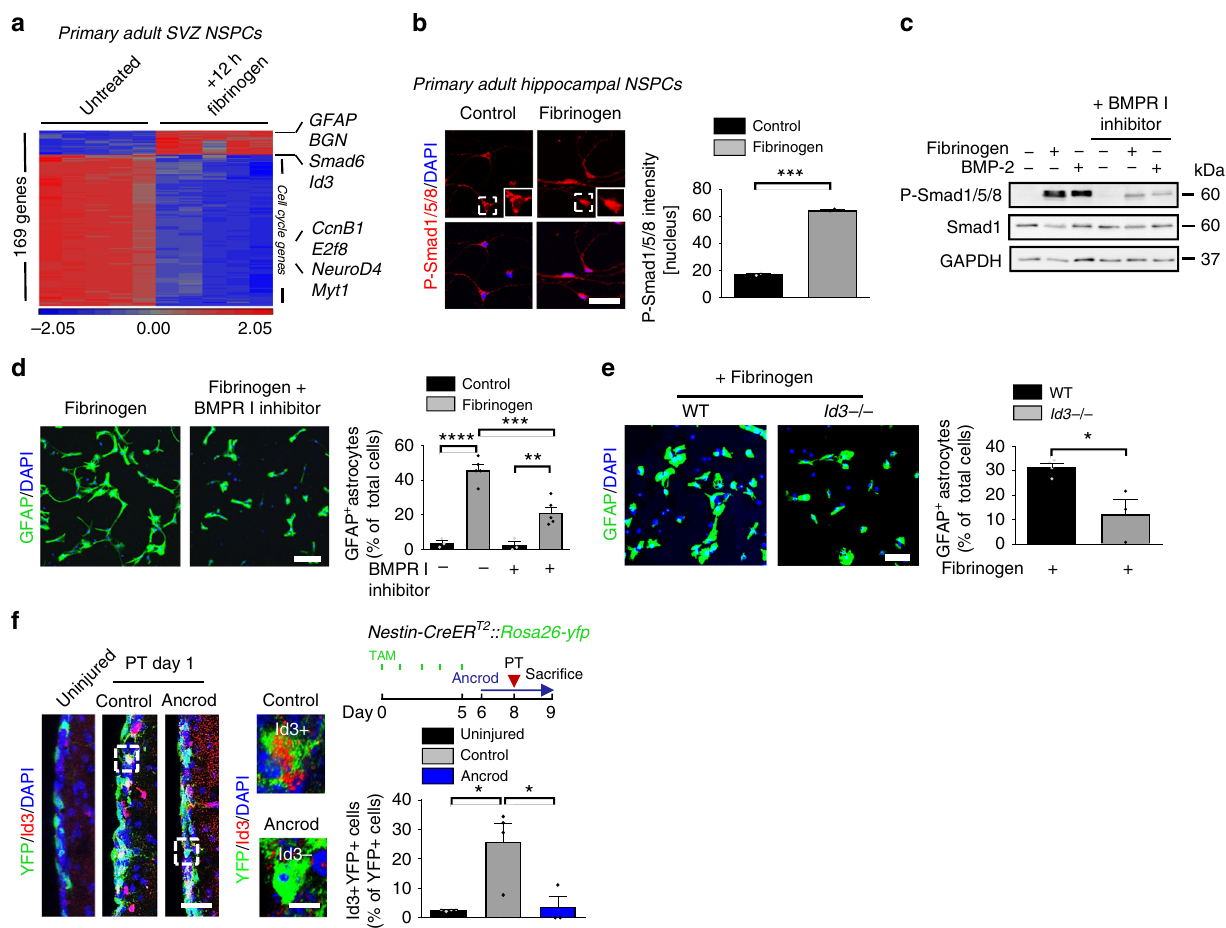
Fig. 3 Fibrinogen induces astrogliogenesis via the BMP – Id3 axis. a Microarray gene expression pro fi le of NSPCs treated for 12 h with fi brinogen compared to control cells. Heatmap analysis showing genes regulated by a factor of at least 4 between fi brinogen-treated and control NSPCs. ( n = 3). b Immunolabeling for phosphorylated Smad1/5/8 (P-Smad1/5/8, red) in fi brinogen-treated hippocampal NSPCs. White boxes indicate enlargement of nuclear P-Smad1/5/8- and P-Smad1/5/8 + cell in untreated and fi brinogen-treated conditions, respectively. Scale bar, 46 μ m. Quanti fi cation of nuclear P- Smad1/5/8. ( n = 2, experiments performed in duplicates (mean ± s.e.m., unpaired Student ’ s t- test, *** P < 0.001). c Immunoblot for P-Smad1/5/8 and Smad1 in NSPCs pretreated with a BMP receptor inhibitor before fi brinogen stimulation. BMP-2 served as positive control. d GFAP + astrocytes in NSPC cultures pretreated with a BMP receptor inhibitor 1 h before fi brinogen treatment 2 days after initiation of differentiation. Scale bar, 125 μ m. Quanti fi cation of GFAP + astrocytes. ( n = 5, (mean ± s.e.m, one-way ANOVA and Bonferroni ’ s multiple comparisons test, ** P < 0.01, *** P < 0.001, **** P < 0.0001). e GFAP + astrocytes (green) in fi brinogen-treated Id3 − / − and WT NSPCs cultures after 2 days on poly ‐ D ‐ lysine. Scale bar, 72 μ m. Quanti fi cation of GFAP + astrocytes. ( n = 4, WT; n = 3, Id3 − / − cells, mean ± s.e.m, unpaired Student ’ s t -test, * P < 0.05). f Experimental setup for photothrombosis on Nestin-CreER T2 ::Rosa26-yfp mice. TAM: tamoxifen (right, top). Id3 (red) and YFP (green) immunostainings in the SVZ of uninjured mice and of ancrod- treated mice compared to control WT mice 1 day after PT. The white boxes indicate the enlargement of an Id3 + YFP + (right, top) and an Id3-YFP + (right, bottom) cell in the SVZ of control mice and fi brinogen-depleted mice, respectively, 1 day after PT. Scale bars, 30 μ m, left and 8 µ m, enlargement. Quanti fi cation of Id3 + YFP + cells in the SVZ per area. ( n = 4 uninjured mice, n = 4 control mice after PT, n = 3 ancrod mice after PT, unpaired Student ’ s t -test, * P < Arg – Gly – Asp (RGD) sequence on its alpha chain, which serves as a with active β 1-integrin on SVZ-derived NSPCs (Fig. 4e) and pre- binding site for integrins 17,32 . β 1-Integrin alters stem cell BMP type treating NSPCs with an integrin-blocking peptide reduced the fi brinogen-mediated NSPC differentiation into astrocytes (Fig. 4f). I receptor localization and attenuates astrogliosis 33 . To examine whether the fi brinogen-integrin interaction was necessary for the Finally, pretreatment of NSPCs with the lipid raft disrupting induction of BMP type I receptor activation and NSPC differ- methyl- β -cyclodextrin reduced fi brinogen-induced P-Smad1/5/8 entiation into astrocytes, we treated primary NSPCs with a plasma- levels by 57% (Supplementary Fig. 7f), suggesting that fi brinogen via derived fi brinogen fraction that lacks most of the fi brinogen alphaC its integrin interacting α C domain induces BMP type I receptor chain including the RGD integrin recognition site (termed Des- α C- localization to lipid rafts to activate BMP signaling. fi brinogen) 34 (Fig. 4b). Treatment of primary NSPCs with the Des- α C- fi brinogen fraction failed to induce Smad1/5/8 phosphorylation Fibrinogen-induced SVZ astrocytes add to cortical scar . Next, in primary NSPCs (Fig. 4c) and NSPC differentiation into astro- cytes (Fig. 4d), suggesting that fi brinogen facilitates BMP receptor we investigated whether fi brinogen-induced SVZ-generated activation via its integrin interacting α C domain inducing NSPC Thbs4 + astrocytes migrated to the cortical lesion area and con- differentiation into astrocytes. In accordance, fi brinogen colocalized tributed to the glia scar after PT. Fibrinogen depletion by ancrod